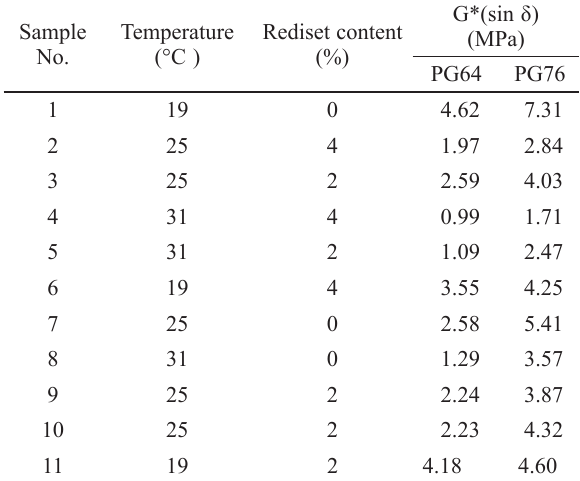
Table 5. Experiment matrix for G*sin δ Sample